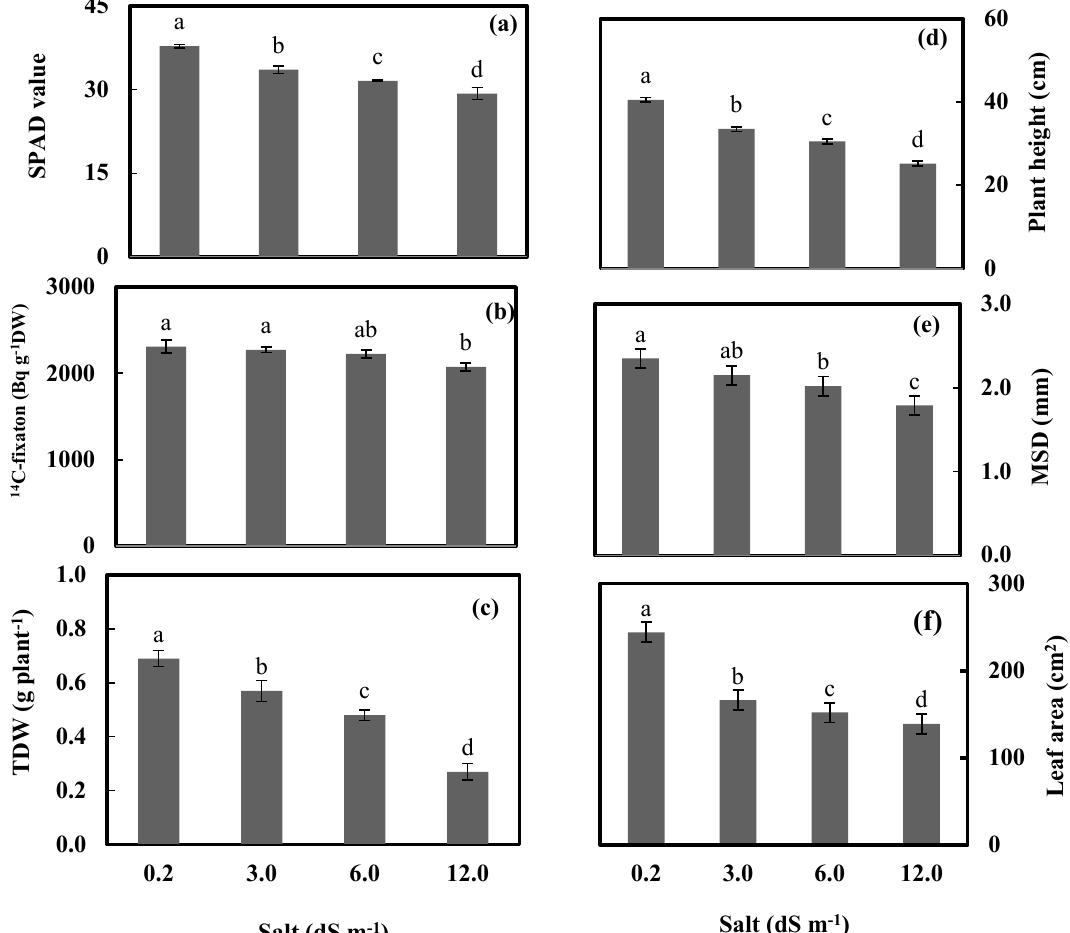
Figure 2. Relative chlorophyll content measured by SPAD meter (SPAD value) ( a ), 14 C–fixaton in Bq g − 1 DW ( b ), total dry weight (TDW) ( c ), plant height ( d ), main stem diameter (MSD) ( e ), and leaf area plant − 1 ( f ) of wheat plants after subjecting at 0.23, 3.0, 6.0, and 12.0 dS m − 1 salt stress for 56 days. Bars represent standard errors. Different letters along with salt treatments indicate significant differences in access treatment means from 6 replications measured at p ≤ 0.05 according to Duncan’s multiple range test.